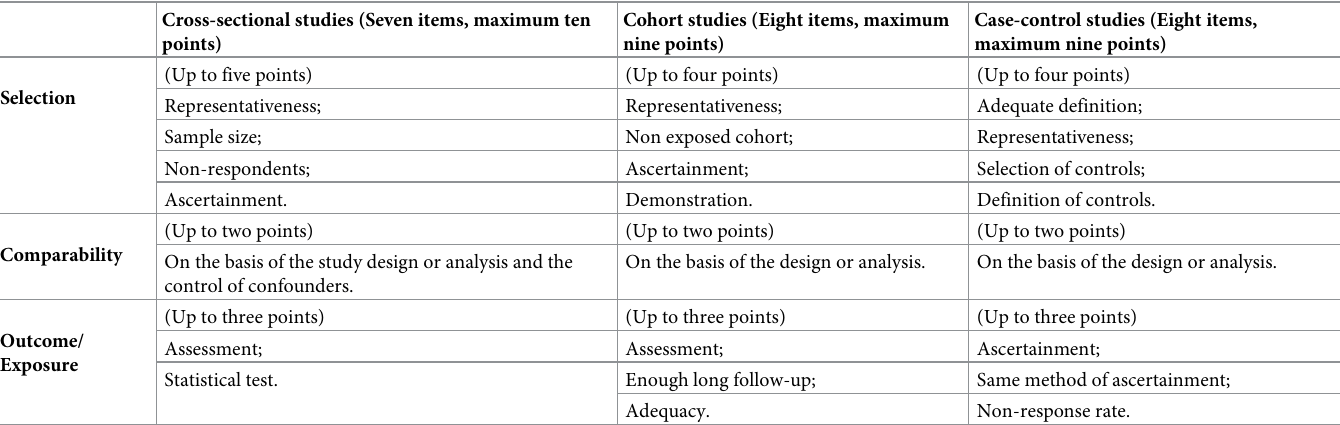
Table 1. The examined selection of observational studies according to NOS. Cross-sectional studies (Seven items, maximum ten points)